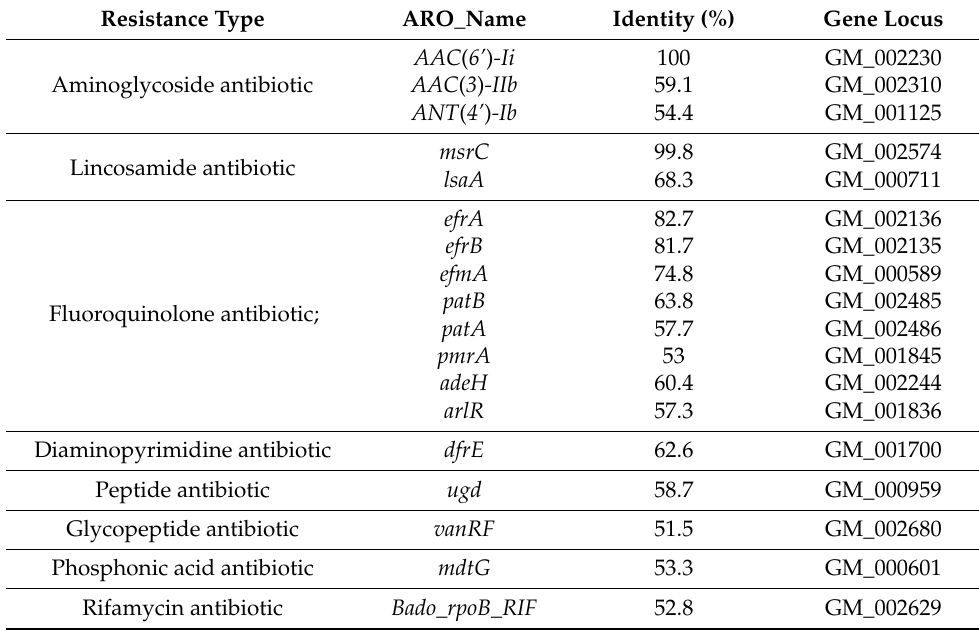
Table 2. Putative antibiotic resistance genes identified in the genome of E. faecium